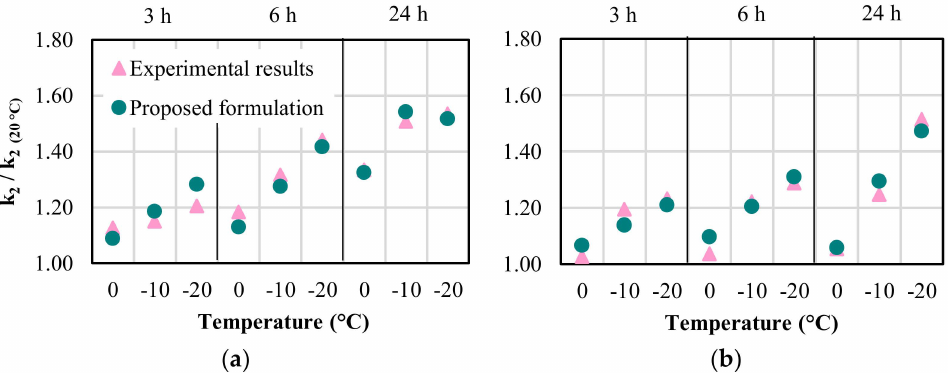
Figure 22. Comparison of experimental amplifications in k 2 with the proposed formulation estima- tions for 0.5 Hz loading frequency at ( a ) 100% and ( b ) 134% shear